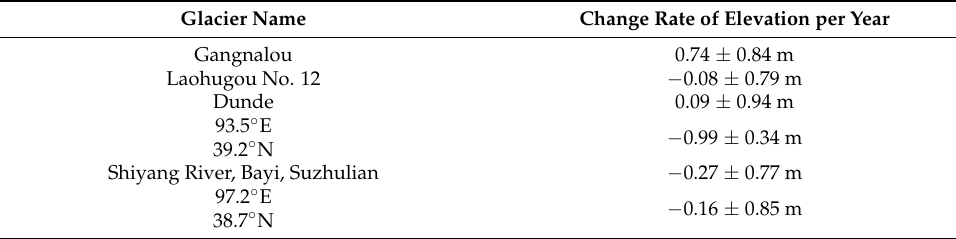
Figure 9. Average annual rate of change of glaciers from 2019 to 2021, where each point represents the median difference of dh between the ICESat-2 data and the ALOSDEM data for that day, and the error bars represent the standard deviation of dh. Red is the nonglacial area, blue is the glacial area, and the dashed line is the annual glacier change rate fitted using the robust least squares regression. Table 3. Average annual rate of change in glacier elevation.